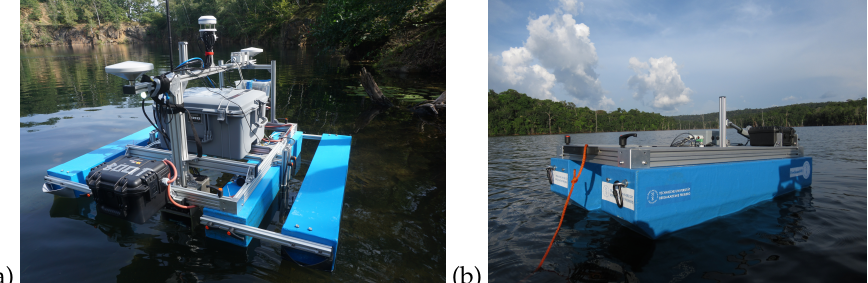
Figure 6. Shows the ( a ) sonar data acquisition with the swimming platform “Ferdinand” at a flooded quarry in Germany and ( b ) the respiration measurement in the wetlands of